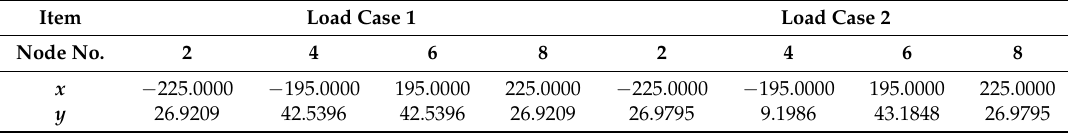
Table 1. Results of y -coordinate under two load cases (unit: m).